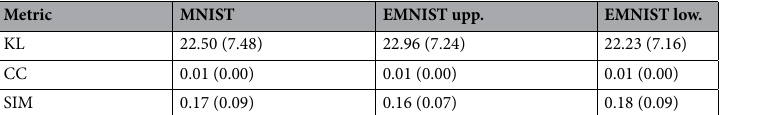
Table 3. Evaluation of fixation maps from RAM for the stimuli presented in the MTurk experiments, averaged over all classes and samplings. Std. dev. are included in parenthesis.